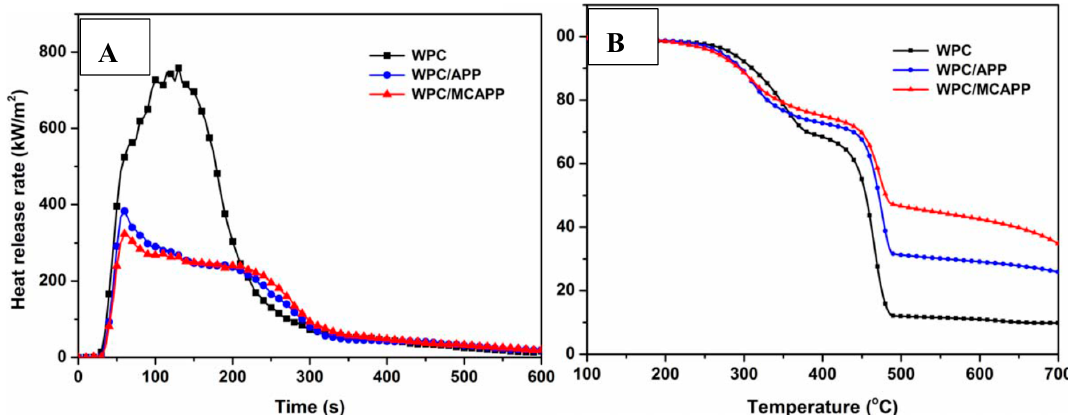
Figure 5. Cone calorimeter HRR ( A ) and TGA, nitrogen flow, heating rate 20° C/min ( B ) of neat WPC, WPC/APP and miceroencapsulated sample WPC/microencapsulated ammonium polyphosphate (MCAPP). Adapted from ref [59] with permission.